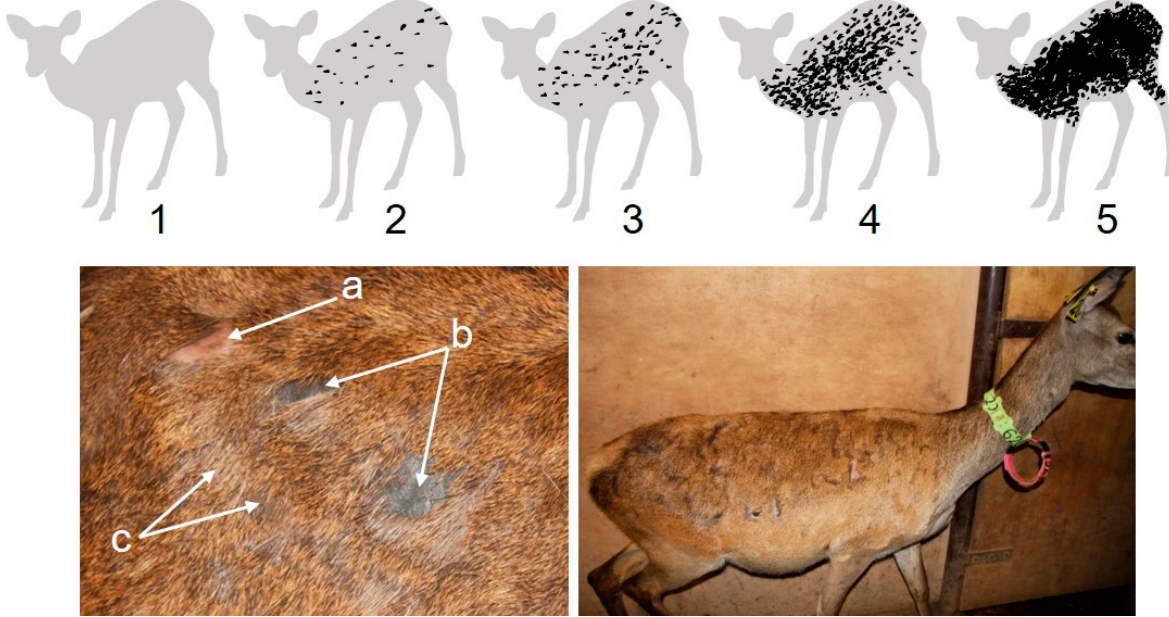
Figure 1. Pelt biting on red deer. Top: pelt biting class 1 to class 5 (see description in section Pelt biting). Light grey is intact pelt; black represents pelt areas that have been bitten. Bottom left: three types of bites on pelt, a. pelt biting has exposed the skin, which is light pink when the bite is recent, hair has been plucked from the root; b. old pelt bites, hairless skin area has turned grey in colour; c. re-grown hair. Bottom right: hind showing pelt biting class 1.75.